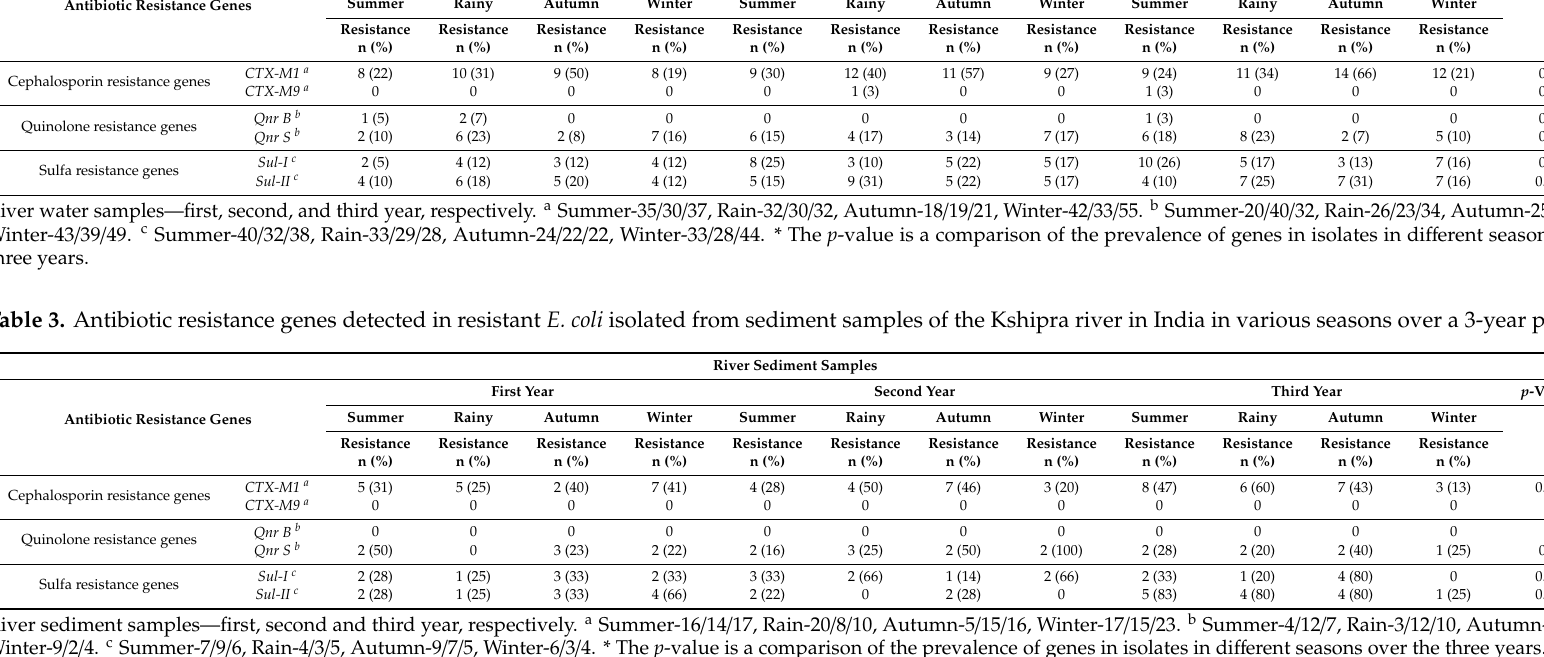
Table 2. Antibiotic resistance genes detected in resistant E. coli isolated from water samples of the Kshipra river in India in various seasons over a 3-year period. RiverWaterSamples FirstYear SecondYear ThirdYear p -Value* Summer Rainy Autumn Winter Summer Rainy Autumn Winter Summer Rainy Autumn Winter AntibioticResistanceGenes